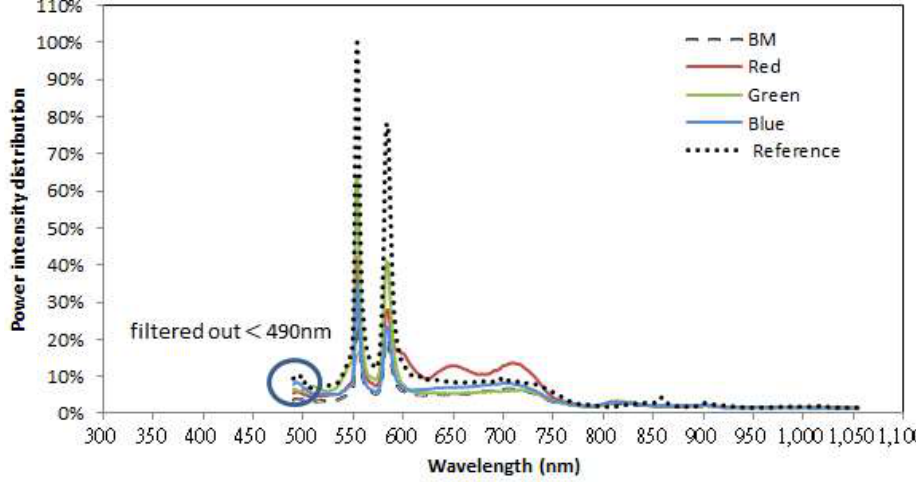
Figure 5. Spectrum distribution (filtered out smaller than 490 nm) for various samples.